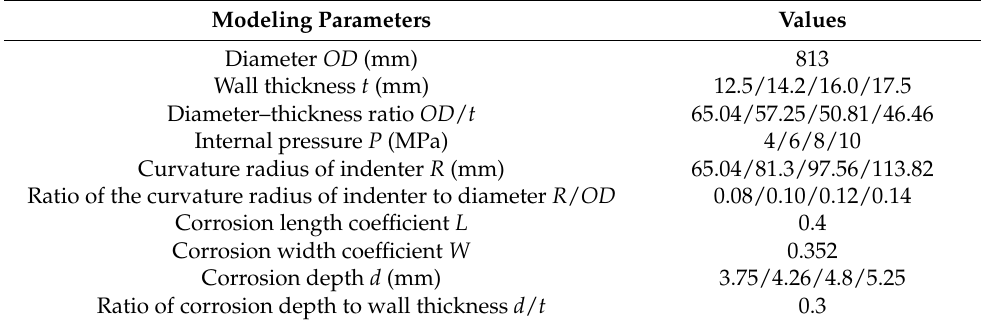
Table 5. Model parameters for analysis of influence of load parameters on dent depth under different conditions.